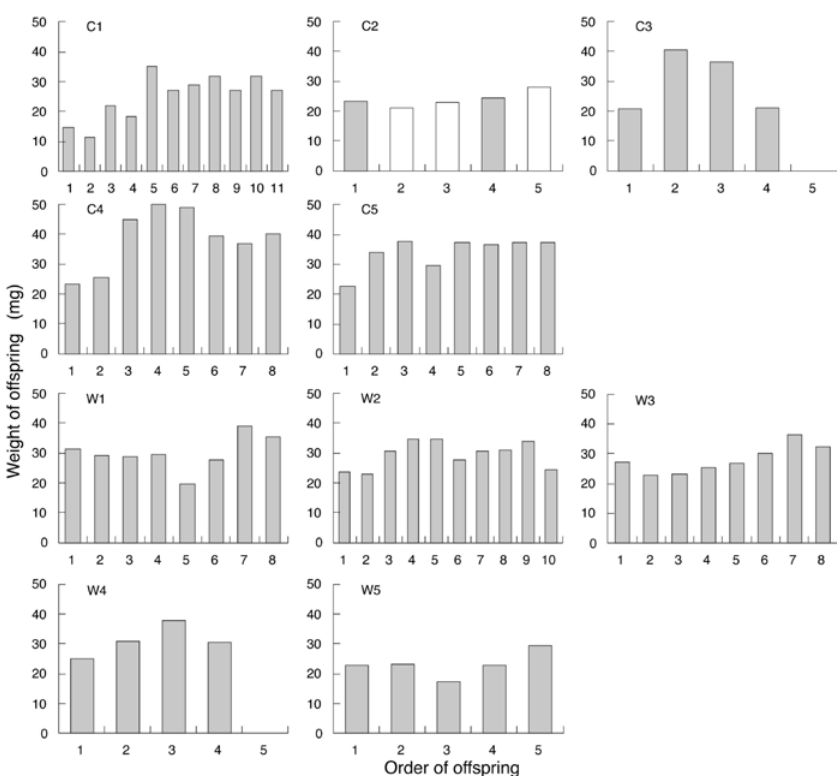
Fig.1 Body weights of foundress-reared adult wasps produced in cold and warm conditions; C1–C5, cold group colonies; W1–W5, warm group colonies. White bars indicate male